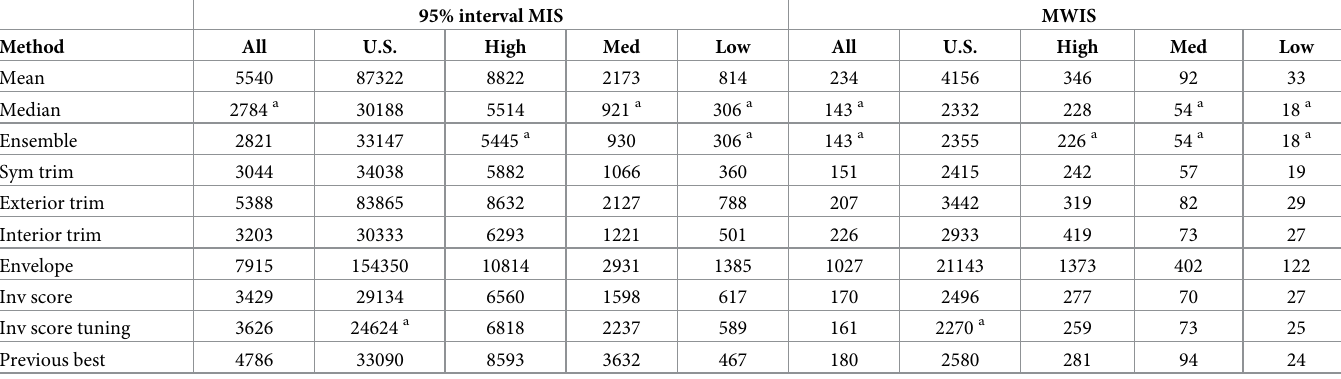
Table 7. For cumulative mortality, 95% interval MIS and MWIS for the 78-week out-of-sample period.